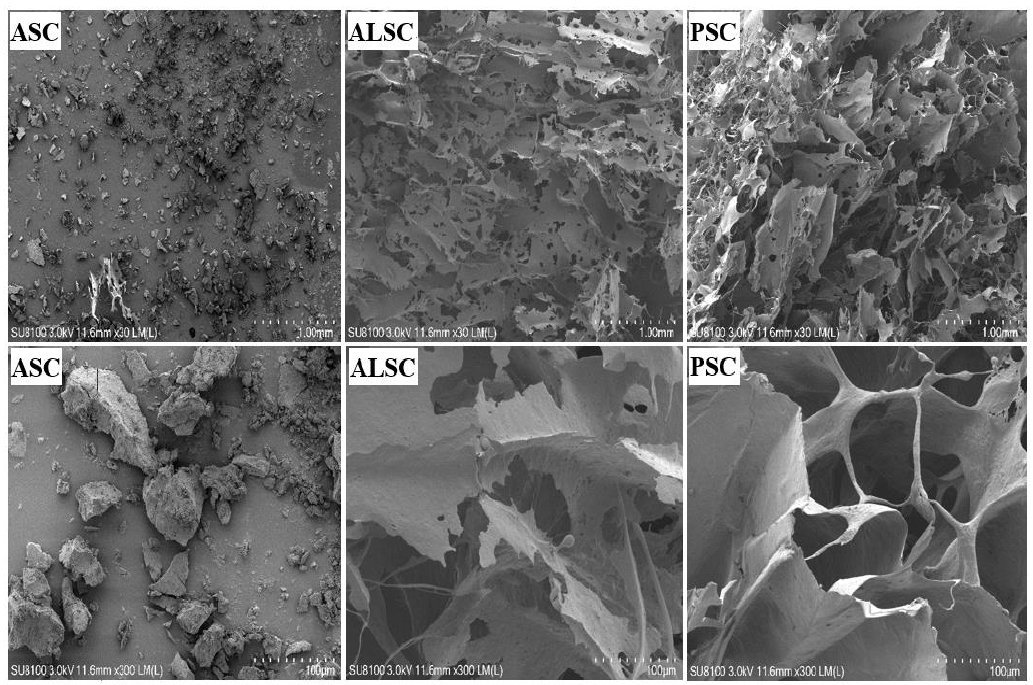
Figure 4. SEM microscopic structure of ASC, ALSC, and PSC (upper row ×30, lower row ×300).